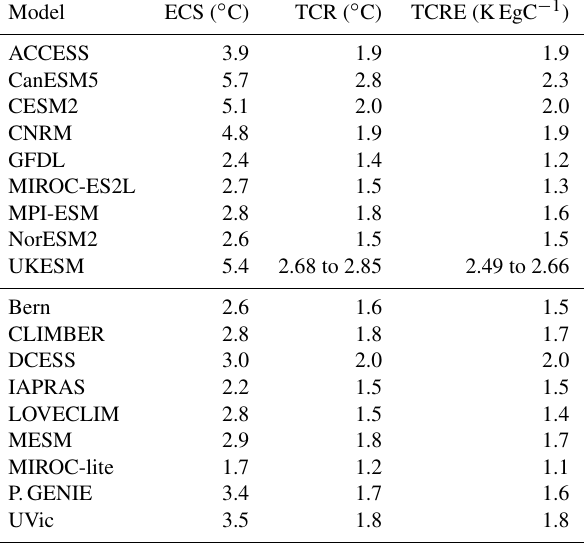
Table 3. Benchmark climate model characteristics for each model: Equilibrium Climate Sensitivity (ECS), Transient Climate Re- sponse (TCR), and Transient Climate Response to Cumulative CO 2 Emissions (TCRE). UKESM reported a maximum to minimum range for TCR and TCRE based on four ensemble members. Model ECS ( ◦